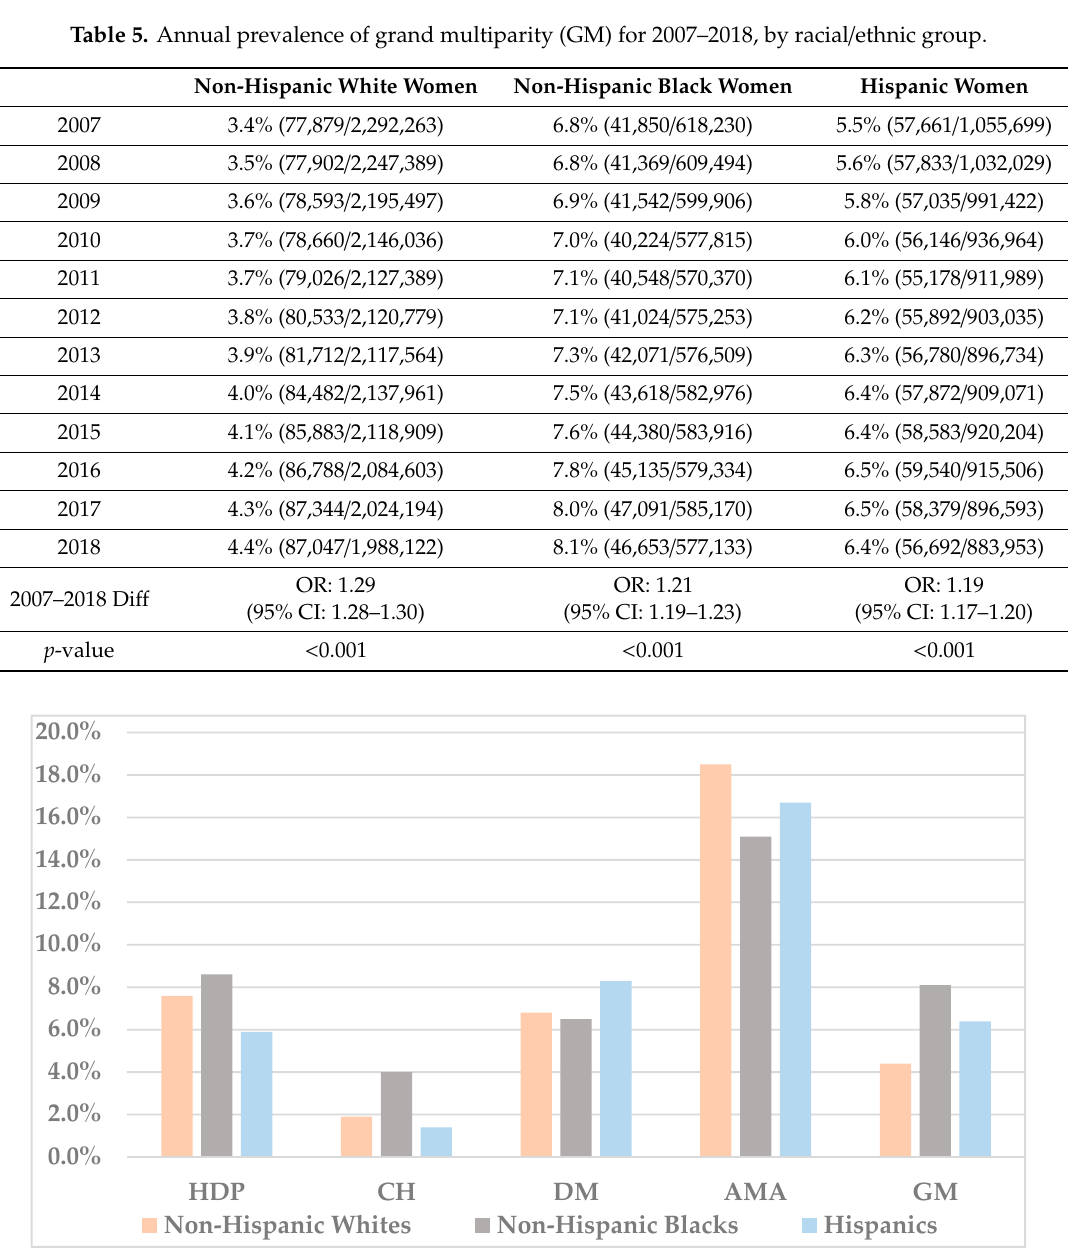
Table 5. Annual prevalence of grand multiparity (GM) for 2007–2018, by racial / ethnic group.